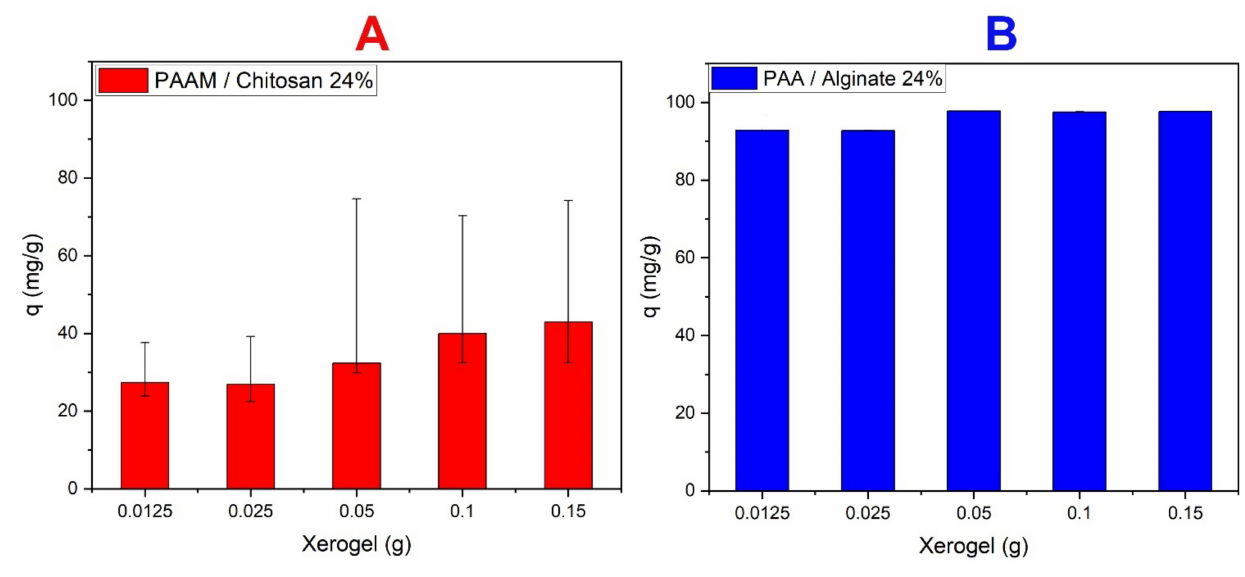
Figure 8. Effect of quantities of xerogels dose (in grams) ( A ) PAAM/chitosan 24% for MO (10 mg/L) removal in pH 3 and ( B ) PAA/alginate 24% for MB (10 mg/L) removal in pH